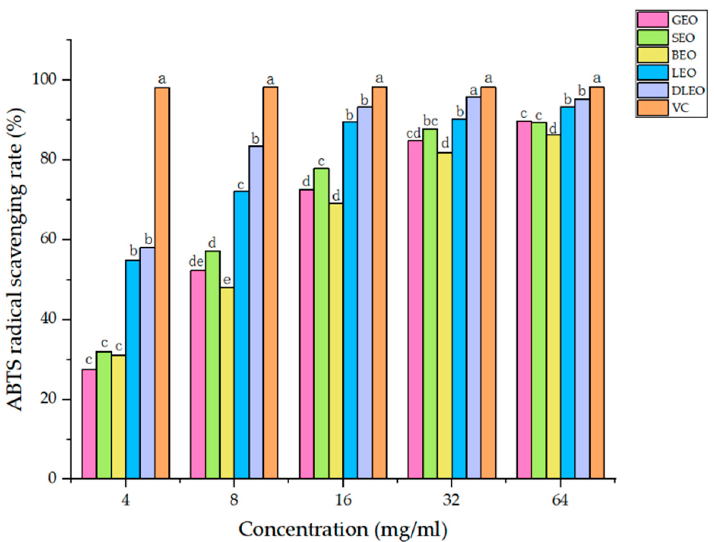
Figure 2. Effect of EO type and concentration on ABTS radical scavenging rate. Type of EO (E) and its concentration (C) had significant effects on ABTS radical scavenging rate ( P E < 0.01, P C < 0.01), and their interaction (E × C) was significant ( P E × P C < 0.01). Different letters show differences ( P <